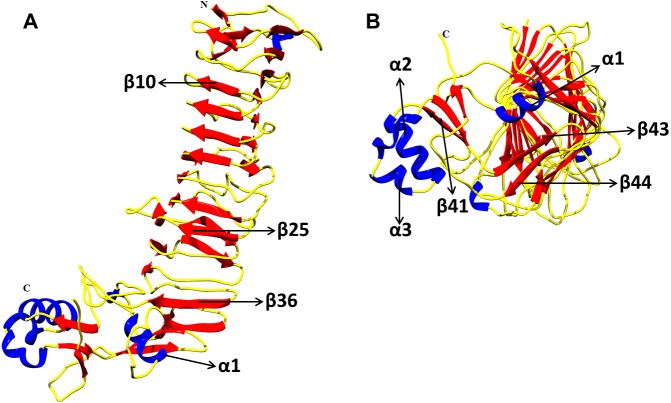
Structure model of p55 VacA from H. pylori of Colombian mestizos.The I-TASSER server (Yang et al., 2015) was used to predict the structure of p55 domain using the protein sequence named as 1,077 from the Colombian samples as query and the crystal structure 2QV3 as template (Gangwer et al., 2007). The root mean square deviation (RMSD), superimposition and surface protein analyses were performed using Chimera v1.11.2 (Pettersen et al., 2004). The conformation of α helixes and the β sheets between the template and the model was strongly similar as displayed. (A) Lateral view; (B) Bottom view.